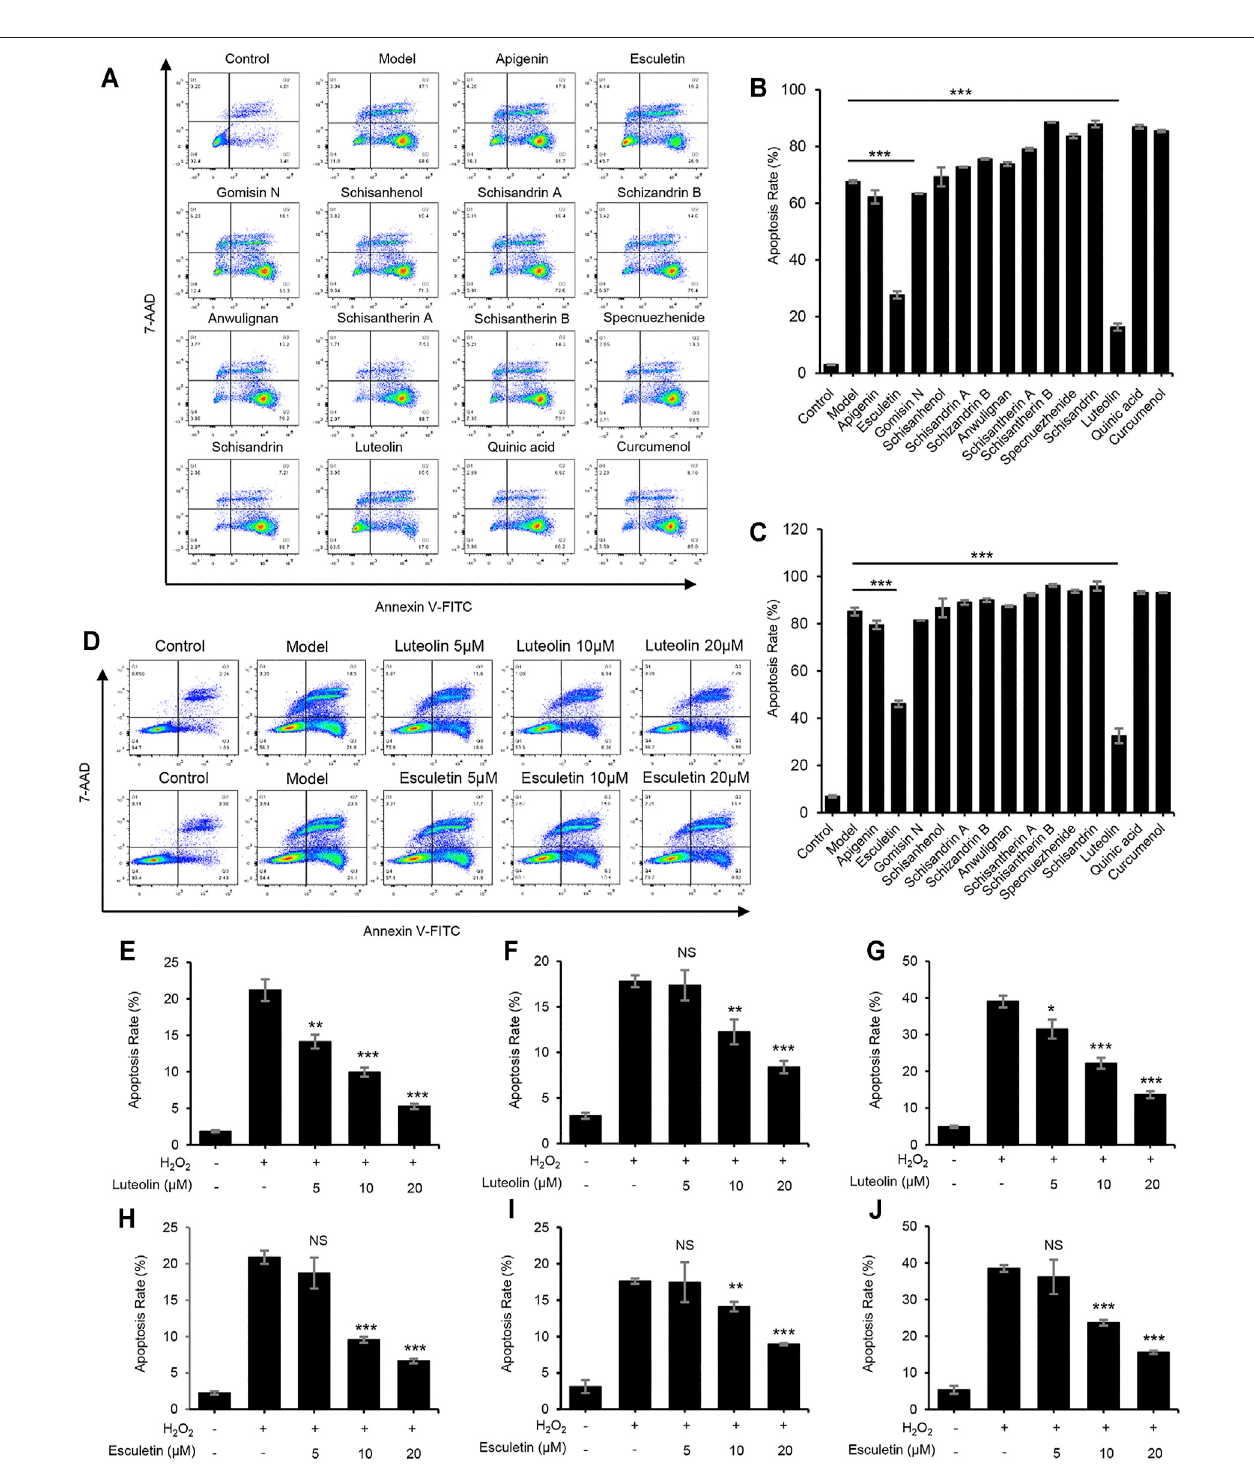
FIGURE 5 | Luteolin and esculetin suppress H 2 O 2 -induced apoptosis. (A) Apoptosis of L02 cells treated with apigenin, esculetin, gomisin N, schisanhenol, schisandrinA,schisandrinB,anwulignan, schisantherin A,schisantherin B,specnuezhenide,schisandrin,luteolin, quinicacid,and curcumenol(40 μ M)and thenexposed toAPAP,asdetectedby fl owcytometry. (B) ThepercentageofearlyapoptoticcellsfromsamplesdescribedinA. (C) Thepercentageoftotalapoptoticcellsfromsamples described inA. (D) Apoptosisof L02 cellstreated with esculetinor luteolin (5,10, and 20 μ M) and then exposedtoAPAP, as detected by fl ow cytometry. (E – G) The percentageofearlyapoptoticcells (E) ,lateapoptoticcells (F) ,andtotalapoptoticcells (G) treatedwithluteolin(5,10,and20 μ M). (H – J) Thepercentageofearlyapoptotic cells (H) ,lateapoptoticcells (I) ,andtotalapoptoticcells (J) treatedwithesculetin(5,10,and20 μ M).Dataarerepresentedasthemean ± SDusingbiologicalsamples.The signi fi cance of the differences was analyzed using unpaired Student ’ s t-test: *p < 0.05, **p < 0.01, ***p < 0.001 vs. the control, NS, not signi fi cant.